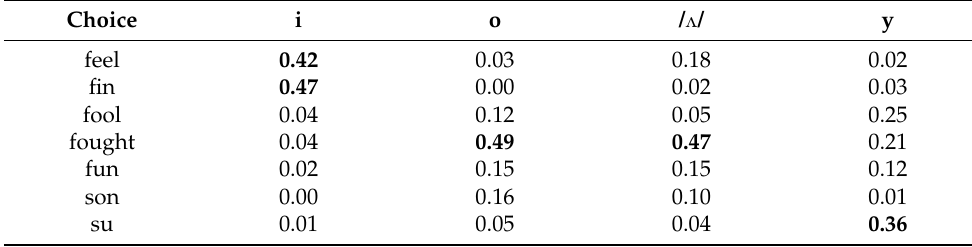
Table 14. The percentage of categorizations of French phonemes in the L1 Spanish